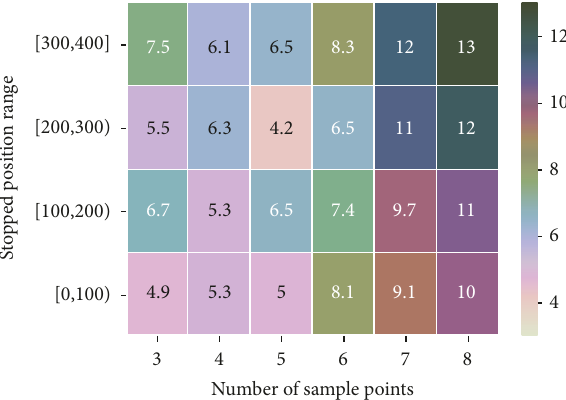
Figure 11: MMAE for different number of sample points and stop position ranges.